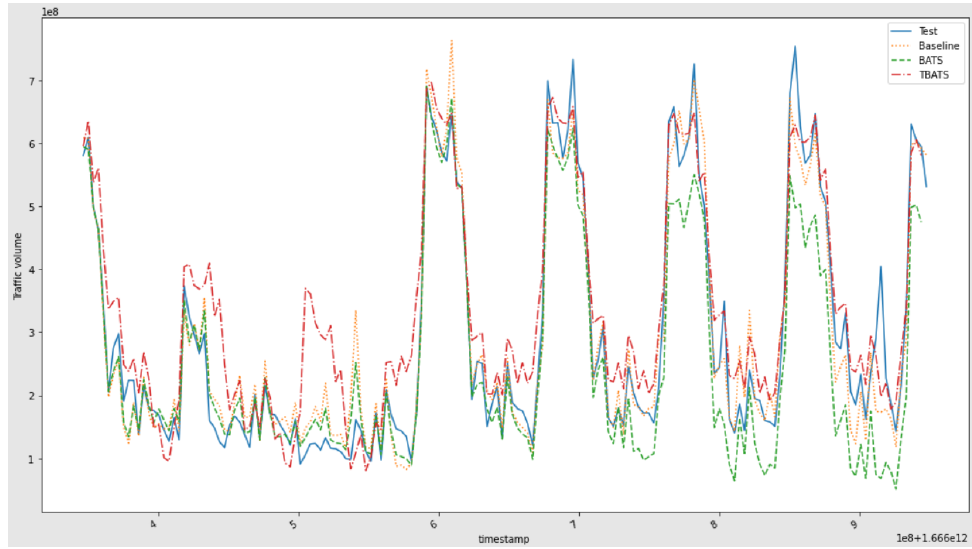
Figure 26. Standard forecasting approach comparison.